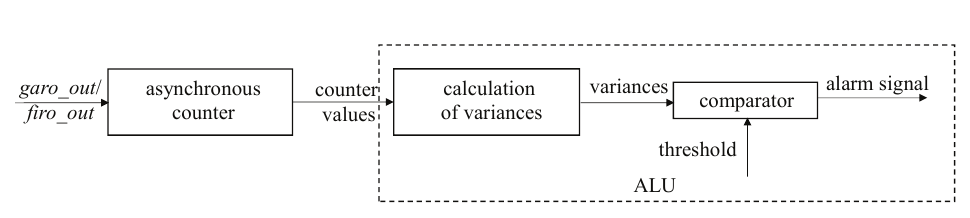
Figure 24: The architecture of